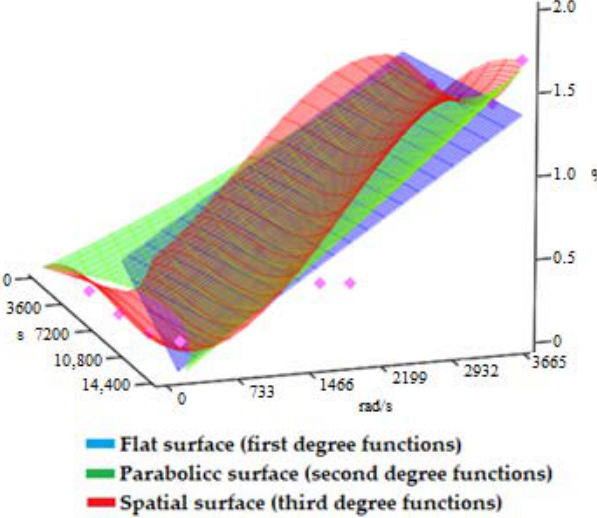
Figure 7. Geometric representation of the interpolation functions of the first degree, second degree, and third degree with two variables, t and ω , for the mass lost by the active side of the dental milling cutter, m w , in the work process.